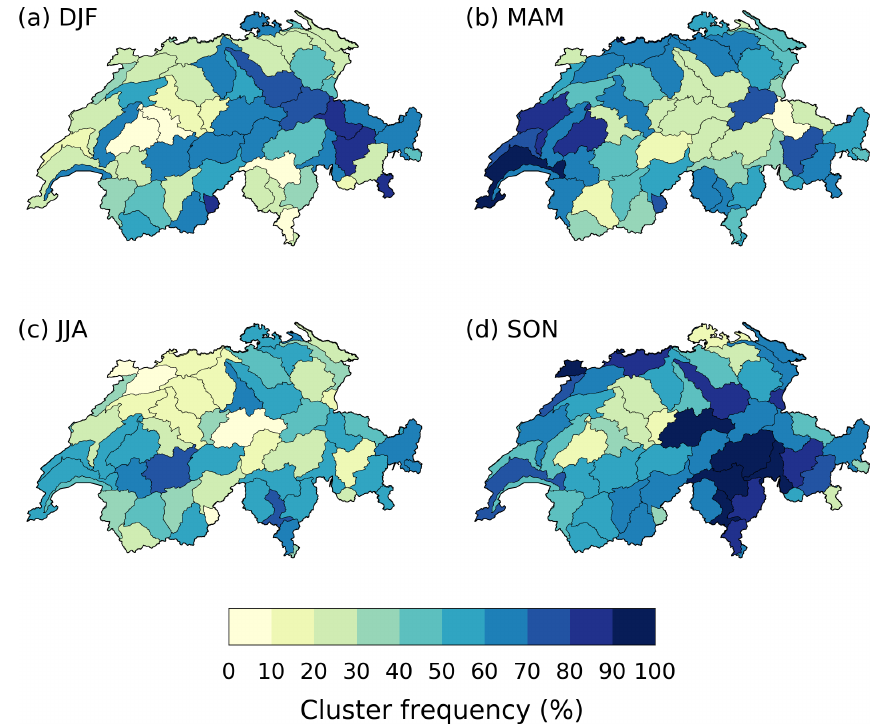
Figure 7. Frequency of extreme precipitation cluster occurrence during extreme 21d cumulative precipitation events ( > 99th percentile) in RhiresD, in (a) DJF, (b) MAM, (c) JJA and (d)